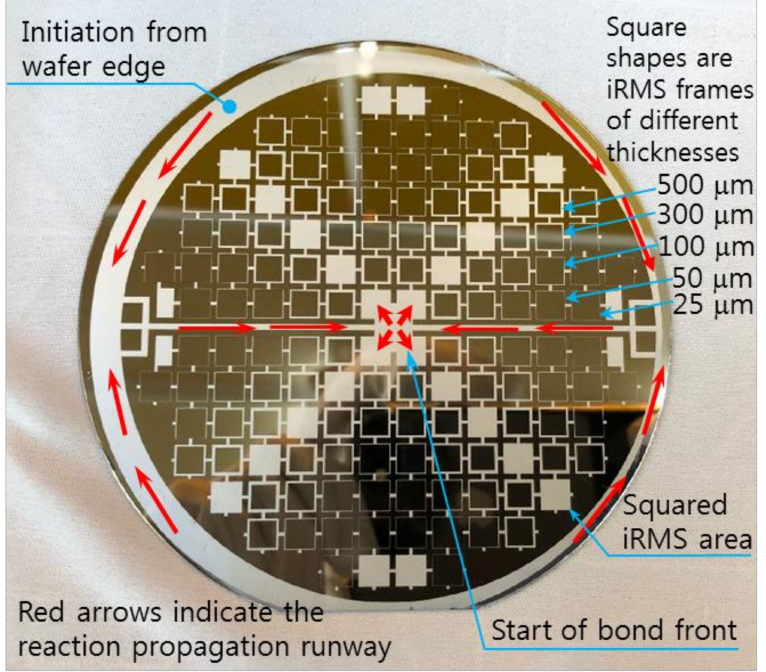
Figure 17. Example of an interconnected patterning design allowing the propagating reaction to run through the entire iRMS on the